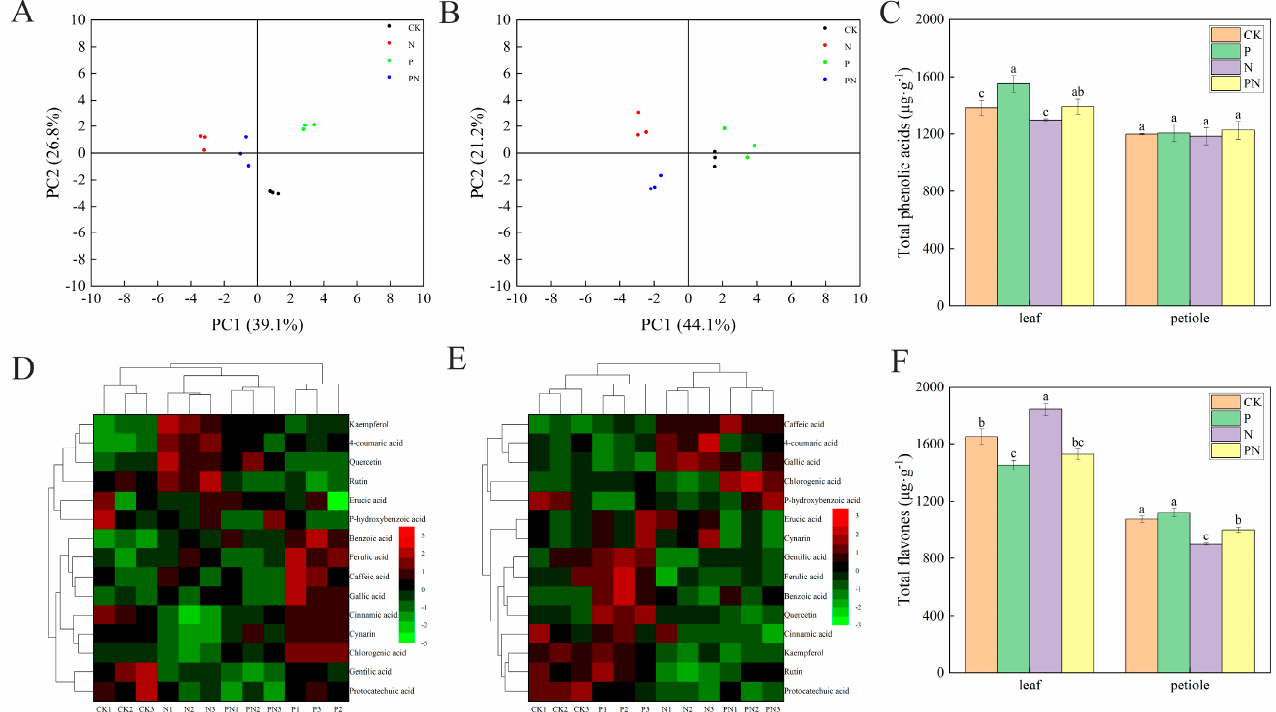
Figure 6. Statistical analysis of exogenous proline effect on bioactive metabolites in celery under salt stress. After planting the 35-day-old seedlings for 7 days, they were treated with 0.3 mM proline solution for 7 days, after which they were watered with 100 mM NaCl solution thrice every 3 days. ( A ) A plot of unsupervised principal component analysis (PCA) scores of phenolic metabolites in celery leaves. ( B ) PCA scores of phenolic metabolites in celery petioles. ( C ) Total phenolic acids. ( D ) Heat map of phenolic compound concentrations in celery leaves. ( E ) Heat map of phenolic com- pound concentrations in celery petioles. The colored areas respond to the concentration of different phenolic compounds in the group treated with exogenous proline under salt stress conditions, from low (green) to high (red). Each row represents one phenolic substance, and each column represents one treatment. ( F ) Total flavones. The results (Figure 6C,F) are expressed as the mean ± SE of three replicates, and the different letters denote the significant difference among treatments ( p < 0.05), according to Duncan’s multiple tests. CK, control. P, 0.3 mM proline. N, 100 mM NaCl. PN, 100 mM NaCl+ 0.3 mM proline.